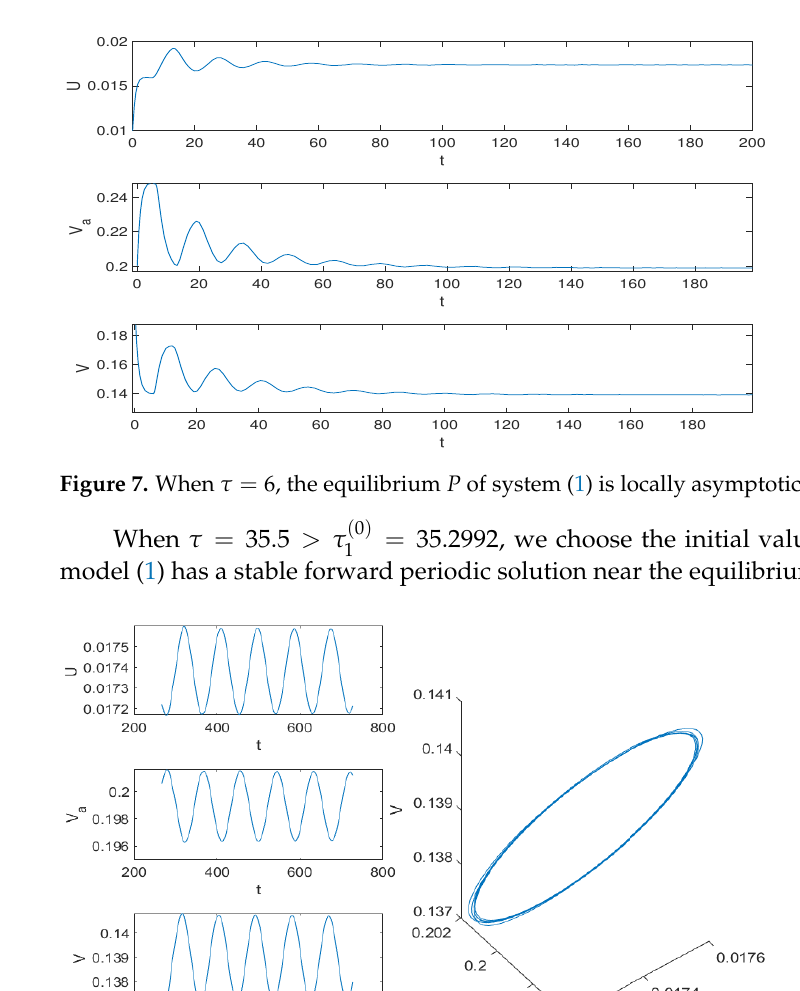
( 0 ) as shown in Figure 1